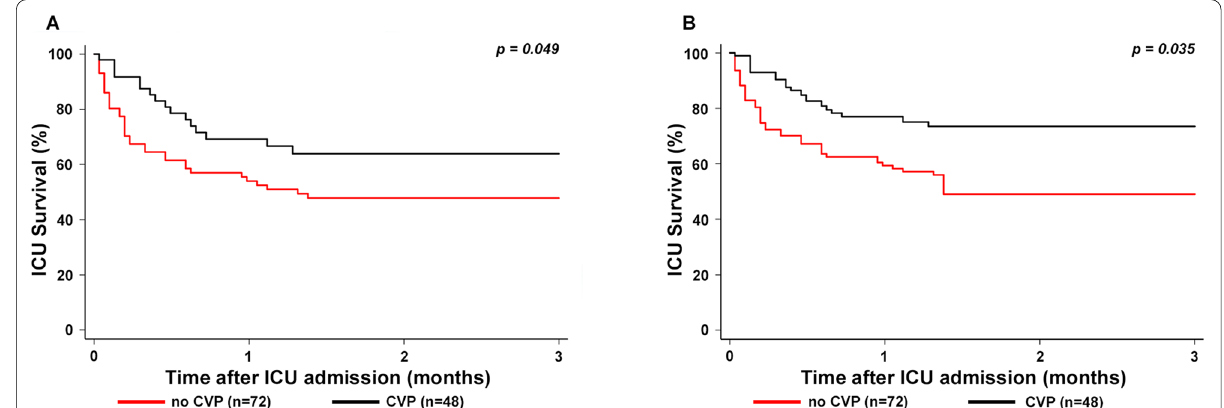
Fig. 2 Survival function according to CVP status. a Unadjusted analysis—median overall survival estimates were not reached in the convalescent plasma (CVP) group and 1.3 month in the non-convalescent plasma (non-CVP) group; 30-day survival estimates were 69% in the CVP group and 54% in the non-CVP group. Statistical significance calculated using the log rank test. A p value < 0.05 was considered statistically significant. b IPTW-weighted analysis—median overall survival estimates were not reached in the convalescent plasma (CVP) group and 1.3 month in